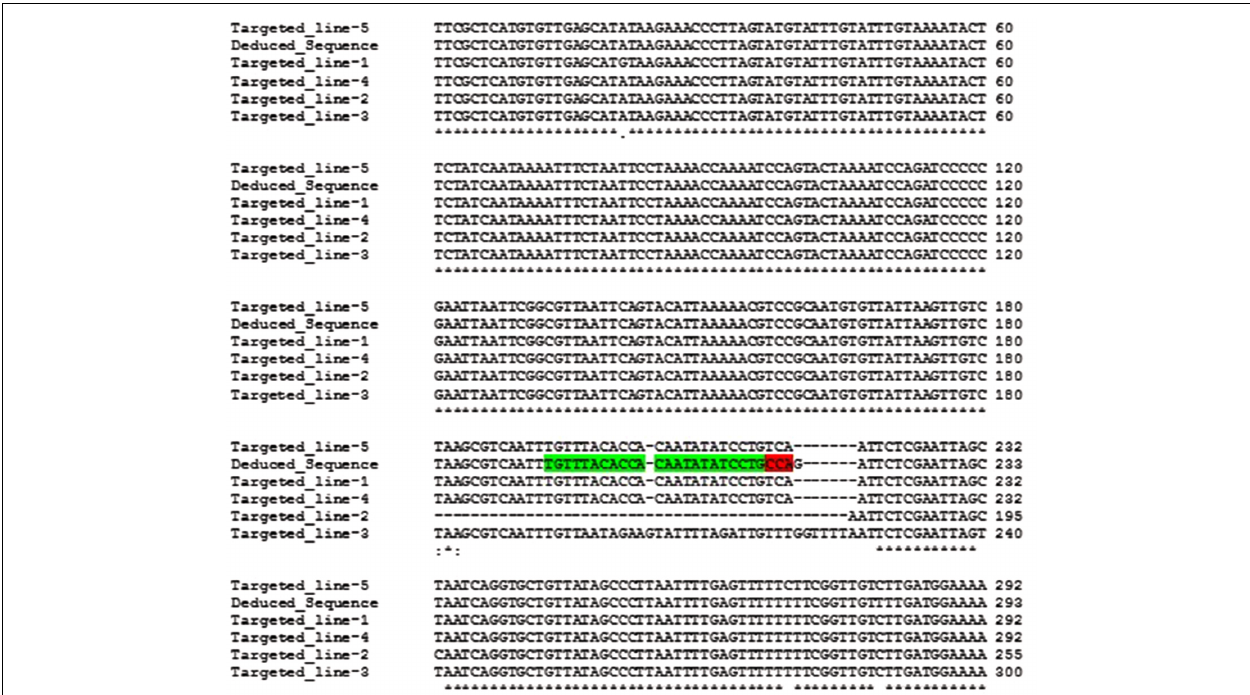
FIGURE 6 | Sequence of LB side flanking region. A pair of primers, one within the endogenous Ubi7 intron and the other within the T-DNA region of the donor vector close to the left border (as shown in Figure 5 ), were used to amplify targeted insertion in the LB junctions. Amplified products were cloned and sequenced. Sequences of five lines are shown here and aligned to deduce the LB junction after targeted integration. The LB sequence is green highlighted in the deduced sequence with the last three nucleotides red-highlighted, which are lost in the perfect LB cleavage events.